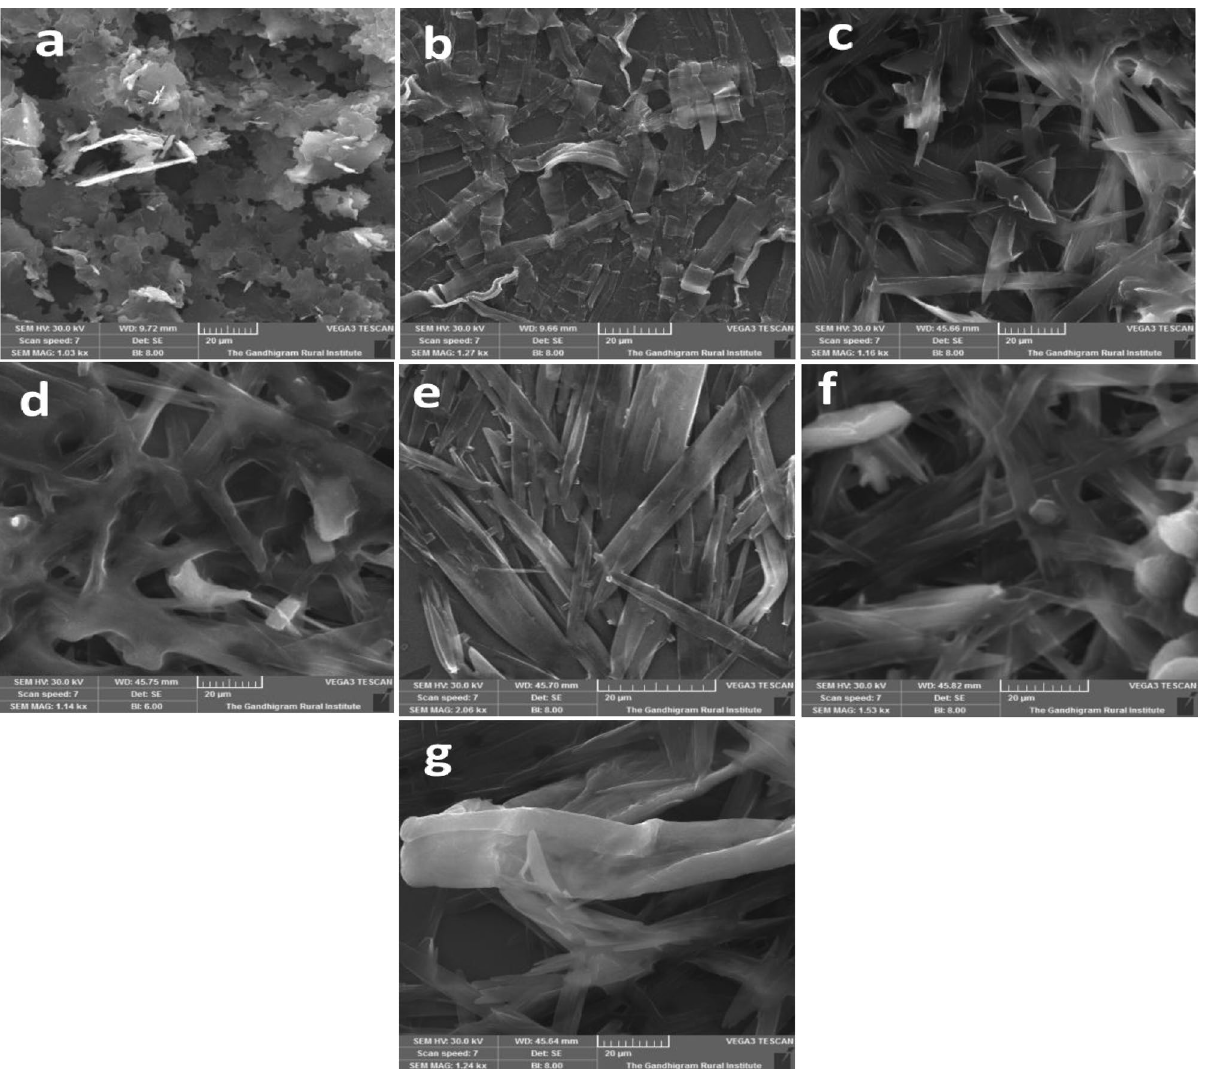
Figure 6. SEM images of D, A and D/A blend films ( a ) D ( b ) A ( c ) 1/1 ( d ) 1/2 ( e ) 1/3 ( f ) 2/1 ( g ) 3/1 with scaling of 20